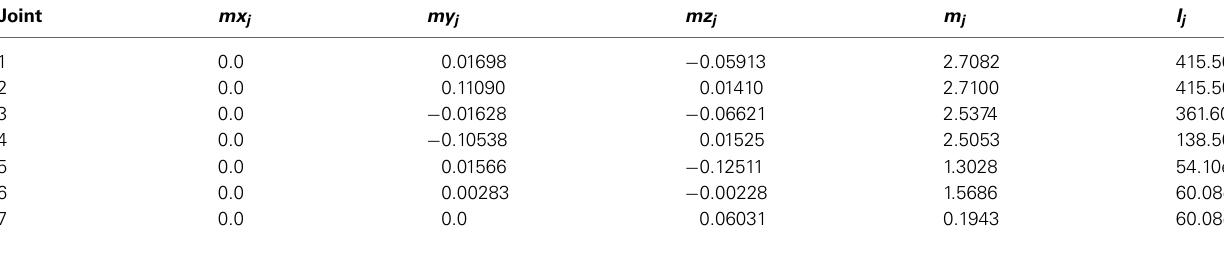
Table B3 | Friction parameters: dry friction ( N · m ) and viscous friction ( N · m · s / rad ) .